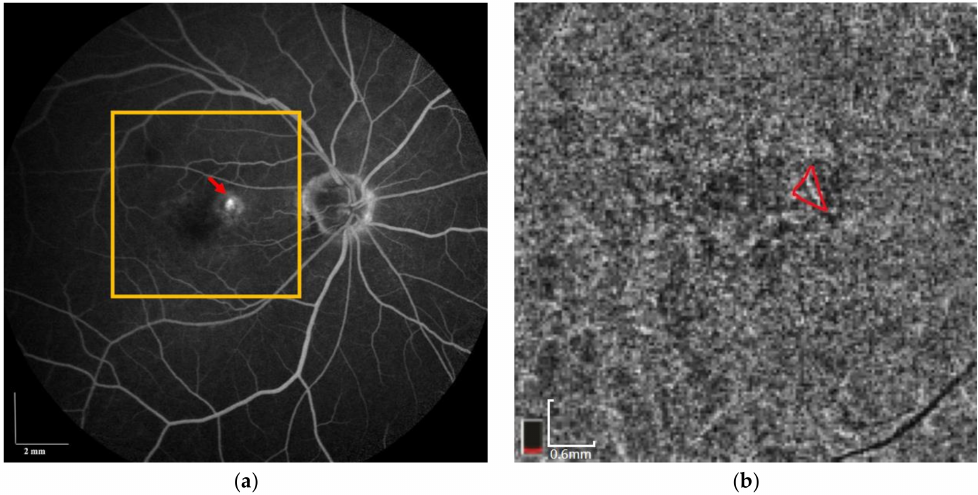
Figure 8. An example of the comparison of ( a ) FA and ( b ) OCTA image. ( a ) Dye leakage on FAG (red arrow) indicates presence of CNV. Orange square indicates the area scanned by OCTA. ( b ) The CNV was detected by our method. FA: fluorescein angiography; OCTA: optical coherence tomography angiography; CNV: choroidal